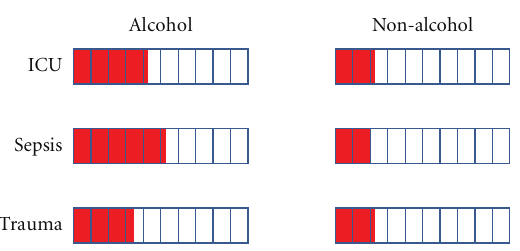
Figure 1: Alcohol abuse increased the incidence of acute respiratory distress syndrome (ARDS) in critically ill patients with an identified at-risk diagnosis. Presented values were adapted from [11]. The red bar indicates the incidence (%) of ARDS when stratified by the at- risk diagnosis and history of alcohol